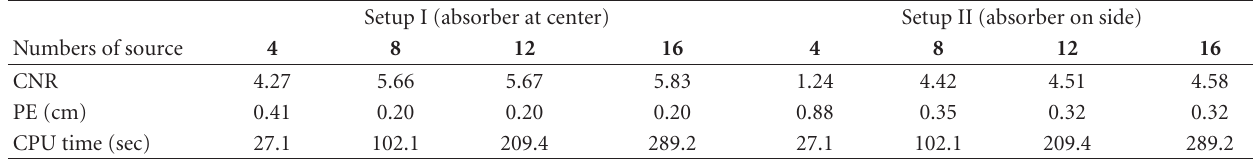
Table 2: Summary of the CNR, PE, and CPU time for di ff erent numbers of sources. Setup I (absorber at center) Setup II (absorber on